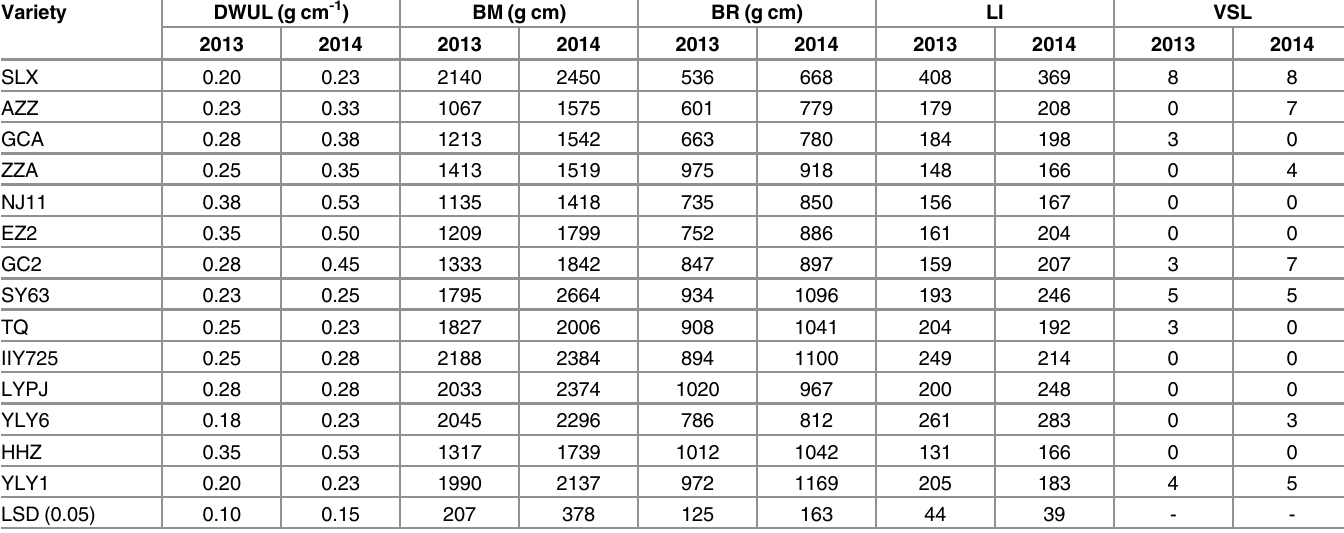
Table 3. Dry weight per unit length of N 3 internode (DWUL), Bending Moment (BR), Breaking Resistance (BR), Lodging Index (LI) and Visual Score of Lodging (VSL) of rice varieties grown in 2013 and 2014 released in different ages since 1930s in China. Variety DWUL (g cm -1